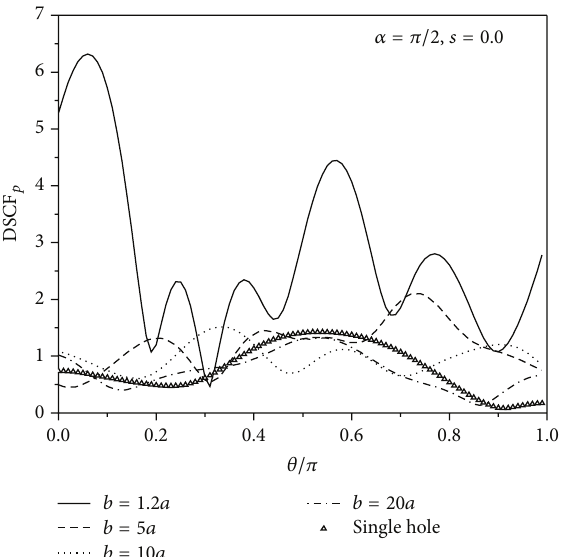
Figure 7: Distribution of DSCF along the middle hole for different separation of 𝑏 for 𝛼 = 𝜋/2 and 𝑠 = 0 .